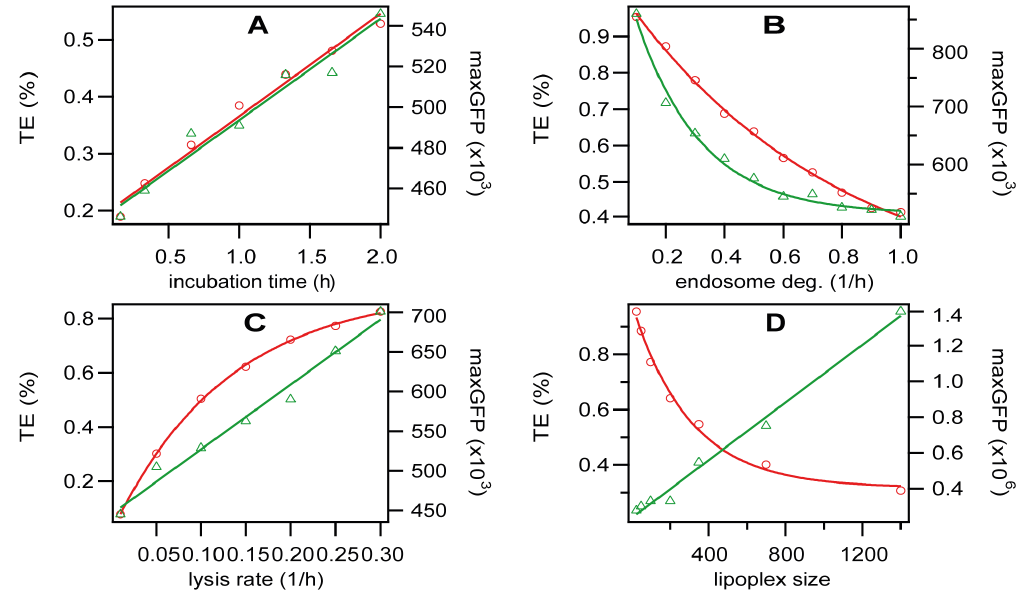
Figure 7. Predictive Modeling. All plots show a parameter vs. transfection efficiency (TE, red circles) and protein expression (GFP, green triangles). The lines are linear or exponential fits. A) Incubation time. B) Endosome degradation rate. C) Lysis rate. D) Lipoplex size.